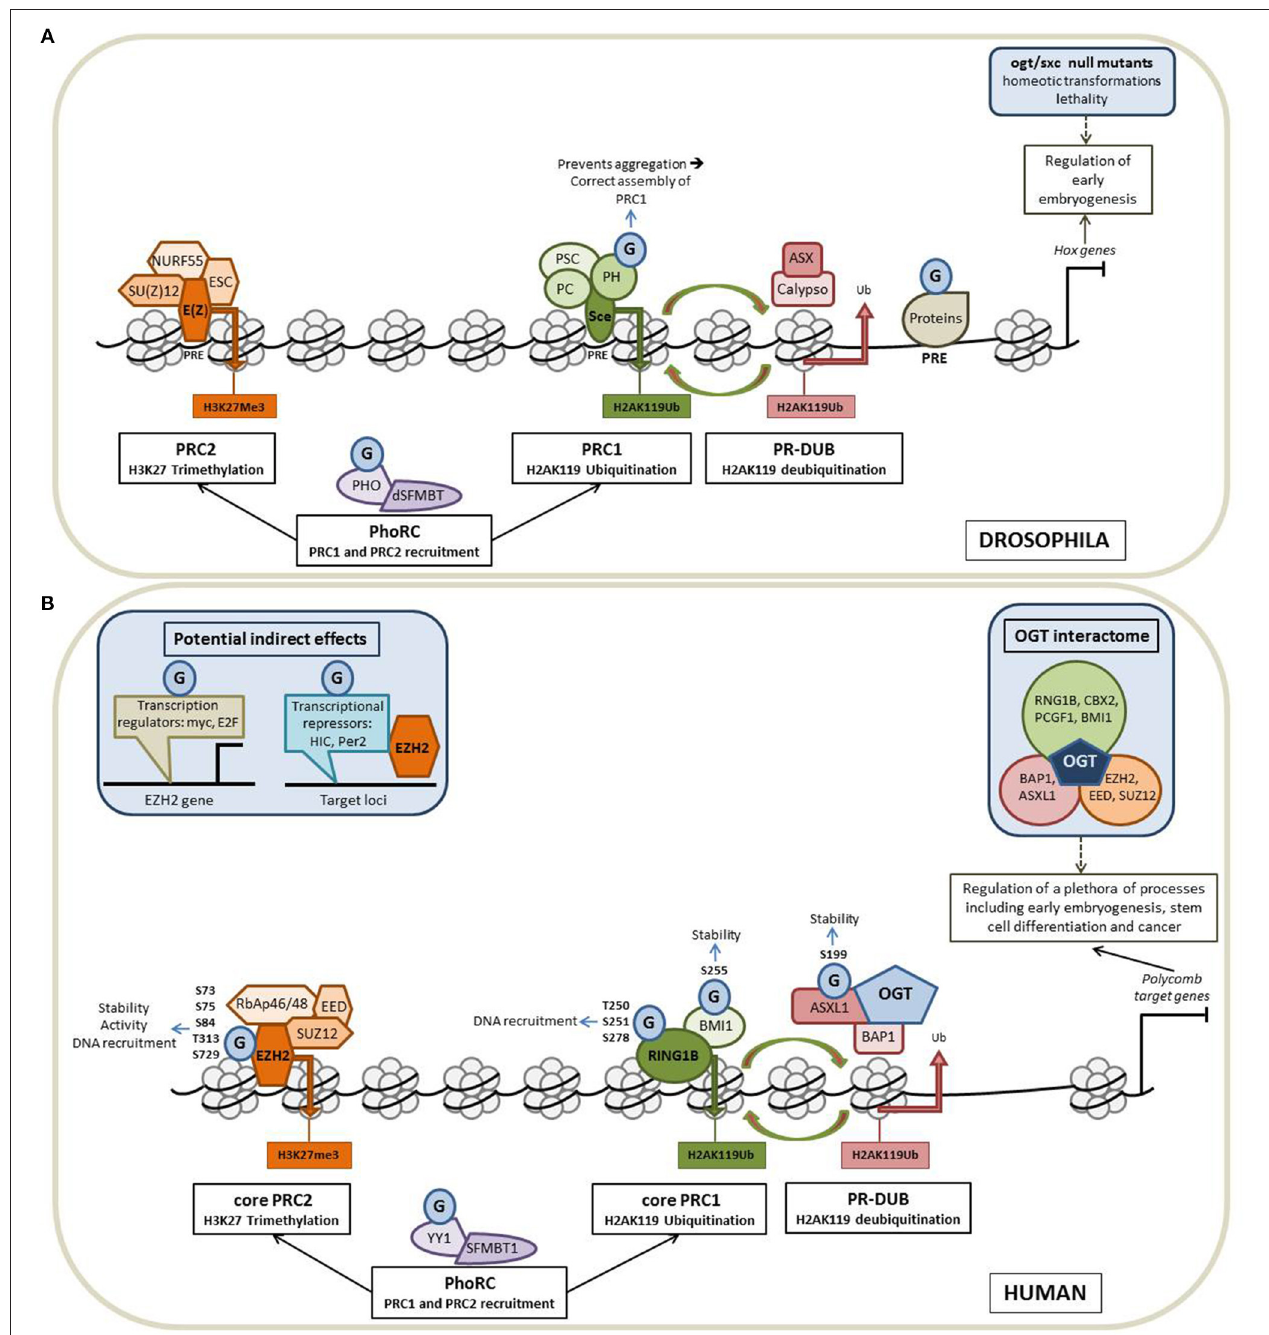
FIGURE 2 | O -GlcNAcylation intimately regulates the Polycomb proteins functions. Schematic representation of the organization of the PcG proteins in Drosophila (A) and in Human (B) and of how O -GlcNAcylation processes contribute to the regulation of the Polycomb-mediated gene repression in the two models. (A) In fly, PcG proteins maintain the repression state of Hox genes whose expression patterns define the establishment of the antero-posterior axis of the embryo. PcG proteins form three broad groups of polycomb repressive complexes (PRCs): PRC1, PRC2 and Polycomb Repressive DeUBiquitinase (PR-DUB). Each PRC modifies and remodels chromatin by distinct mechanisms tuned by variable compositions of core and accessory subunits. The core PRC1 is composed of PH, PSC, PC, and Sce that catalyzes H2AK119 ubiquitination. This repressive mark can be removed by the PR-DUB complex (association of Calypso and ASX). NURF55, SU(Z)12, ESC, and E(Z) forms the PRC2 core complex in which E(Z) has a H3K27 methylation activity. The fourth complex, PhoRC (association of PHO and dSFMBT) helps the recruitment of PRC1 and PRC2 to their target genes. PcG proteins are recruited to their target genes through the recognition of well-characterized regulatory DNA sequences called PREs (Polycomb Responsive Elements). OGT is also a PcG protein encoded by the supersexcomb ( sxc ) gene and O -GlcNAcylation regulates the PcG mediated repression at several levels (see the text for more details). G: O -GlcNAcylation. (B) In Human, PcG proteins repress numerous genes regulating a